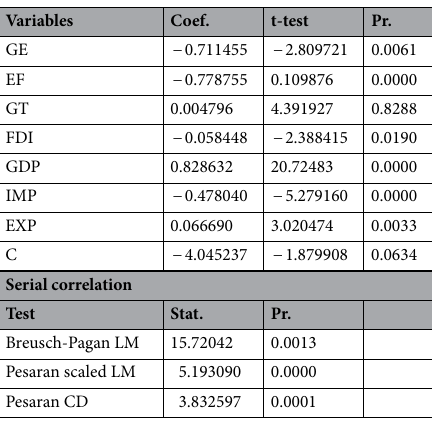
Table 3. Baseline Model.